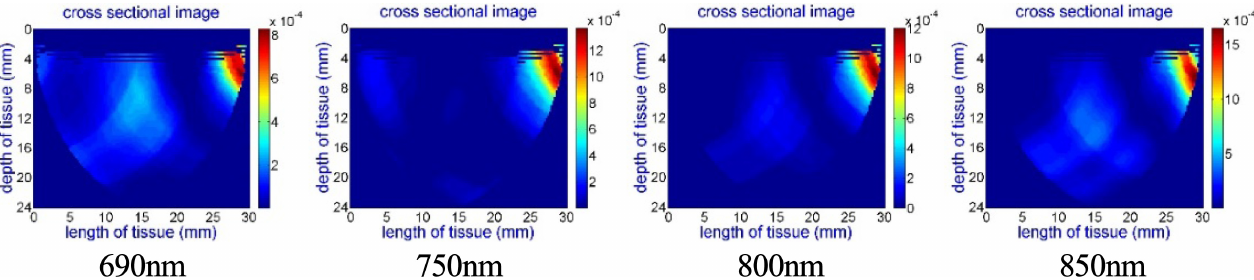
Fig. 11. Case study #1: reconstructed images from collected data using the DOB-Scan probe in four di®erent wavelengths, right breast, healthy.